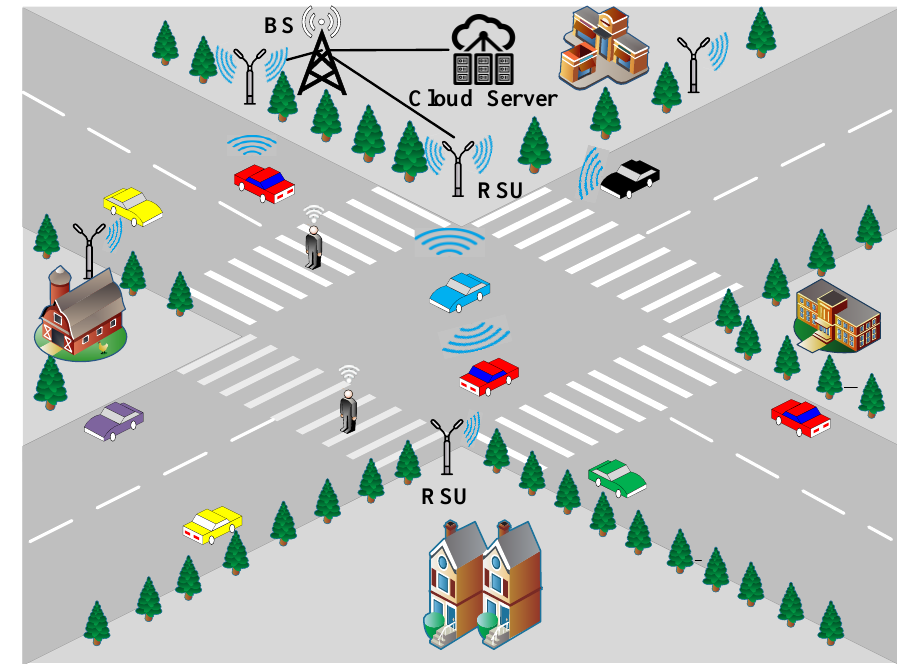
Figure 1. 6G V2X classic communication scenario.